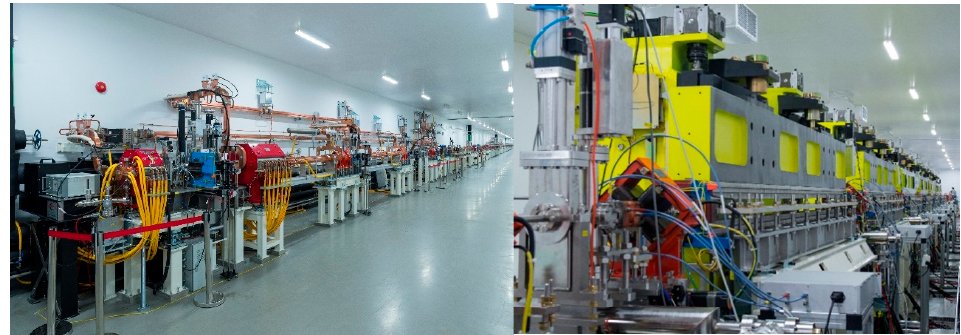
Figure 10. The SXFEL linac ( left ) and undulator ( right ).